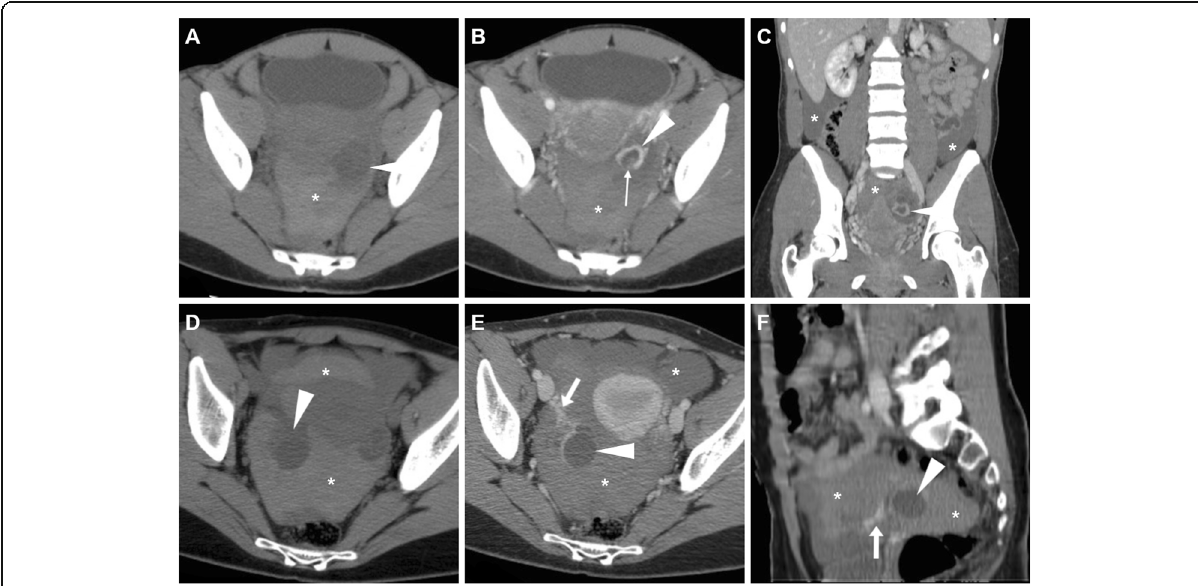
Fig. 13 Two cases of haemoperitoneum from bleeding corpus luteum. a – c Unenhanced ( a ) and post-contrast ( b , c ) CT show hyperattenuating effusion (asterisk) in pelvis and paracolic gutters, mildly enlarged left ovary containing a characteristic corpus luteum (arrowheads) with focal discontinuity (thin arrow in b ) of its strongly enhancing crenulated wall. d – f Unenhanced ( d ) and post-contrast ( e , f ) CT images show pelvic blood (asterisk) surrounding a 3-cm cystic lesion of the right ovary (arrowheads), from which contrast extravasated (arrows in e and f ) indicating active